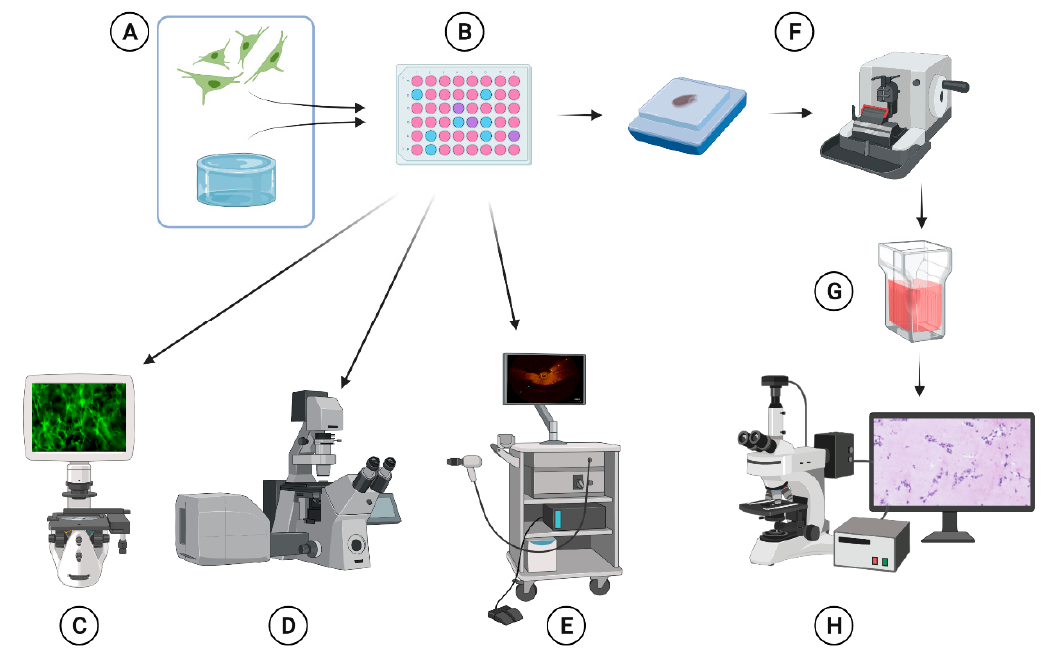
Figure 9. Schematic representation of the methodology. HPMEC were mixed with pregel ( A ) and cast in 48-well plates at 37 °C ( B ). Visualization of cells was performed via inverted fluorescence microscopy ( C ), the use of a live cell confocal imaging system ( D ), and OCT ( E ). After culture, the gels were fixed with paraformaldehyde, embedded into the paraffin, and thin-sectioned ( F ). The sections were subjected to different (immuno)histochemical staining ( G ) and imaged by microscopy ( H ). [Image partially made with BioRender.] [23].